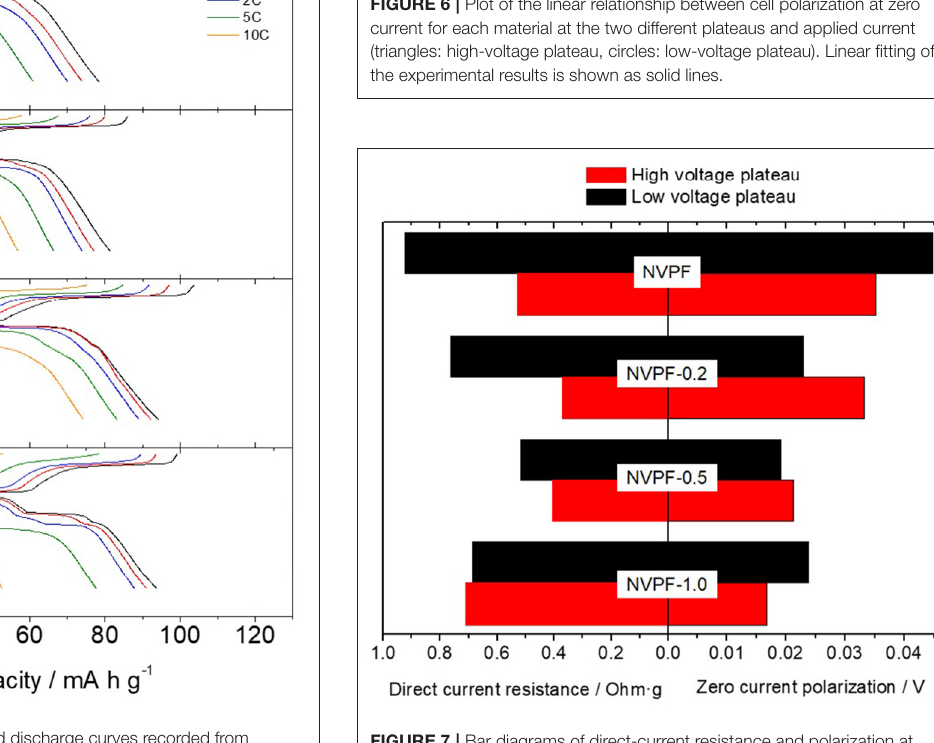
FIGURE 7 | Bar diagrams of direct-current resistance and polarization at zero-current